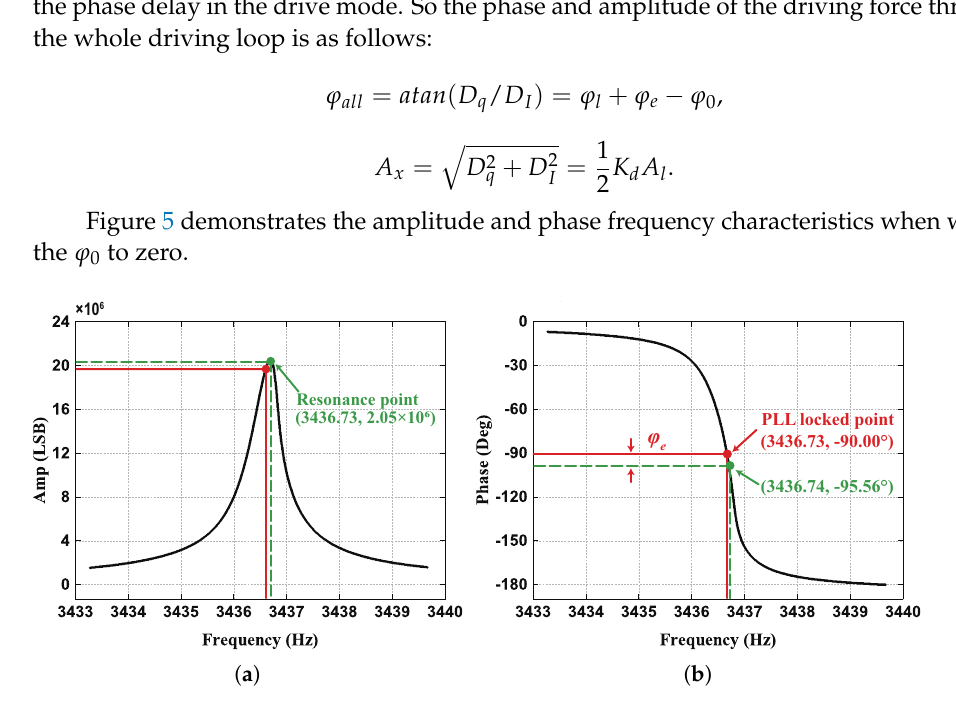
Figure 5. ( a ) The results of the phase-frequency characteristics. ( b ) The results of the amplitude- frequency characteristics. (The red solid line represent the actual condition, the green dashed line represent the resonant